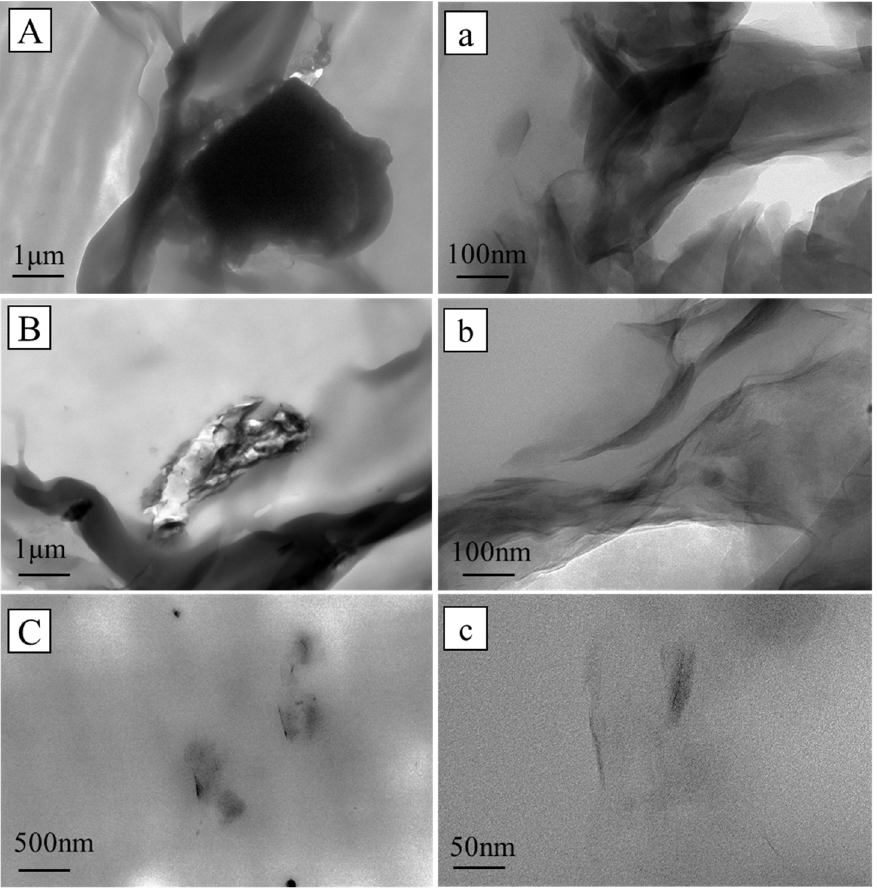
Figure 12. TEM image of PP composites. ( A , a ) PP/CaMMT; ( B , b )PP/TCPP + CaMMT-2/1; ( C , c ) PP/TCPP-CaMMT-2/1.